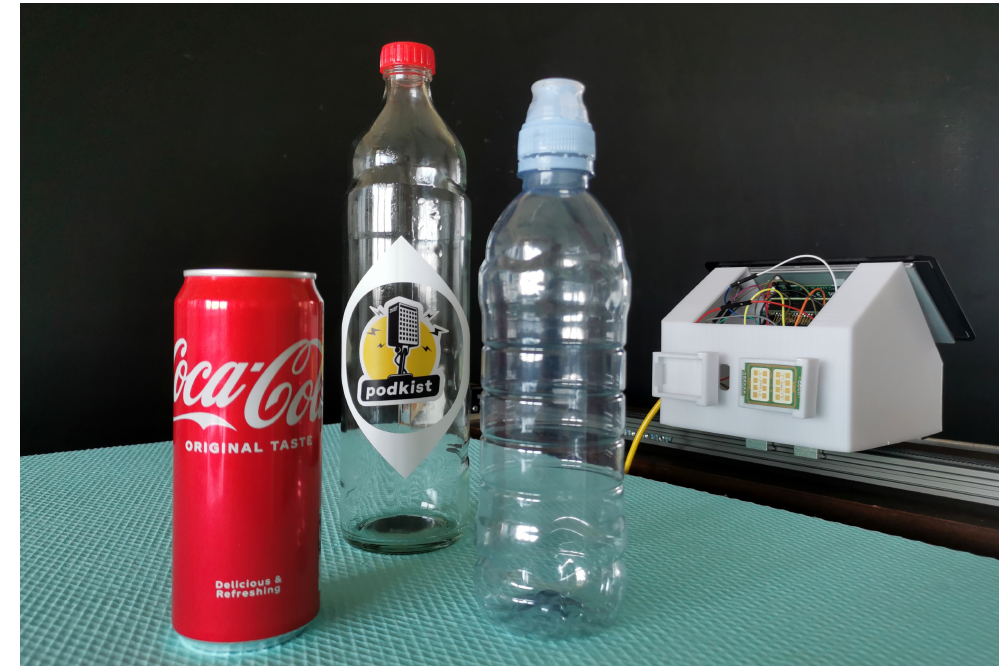
Figure 4. RealSAR objects: aluminium, glass and plastic bottle, and